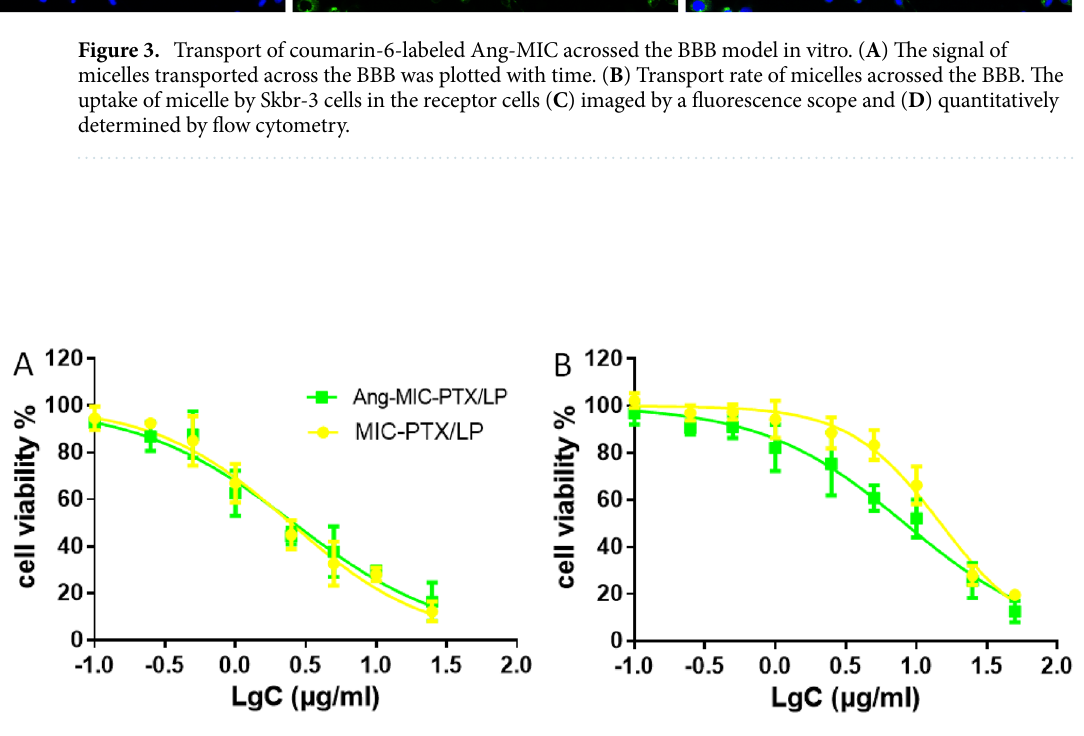
Figure 4. Cell viability of ( A ) SKBr-3 cells and ( B ) 4T1 cells after treated with different concentrations of Ang- MIC-PTX/LP. MIC-PTX/LP group was used as